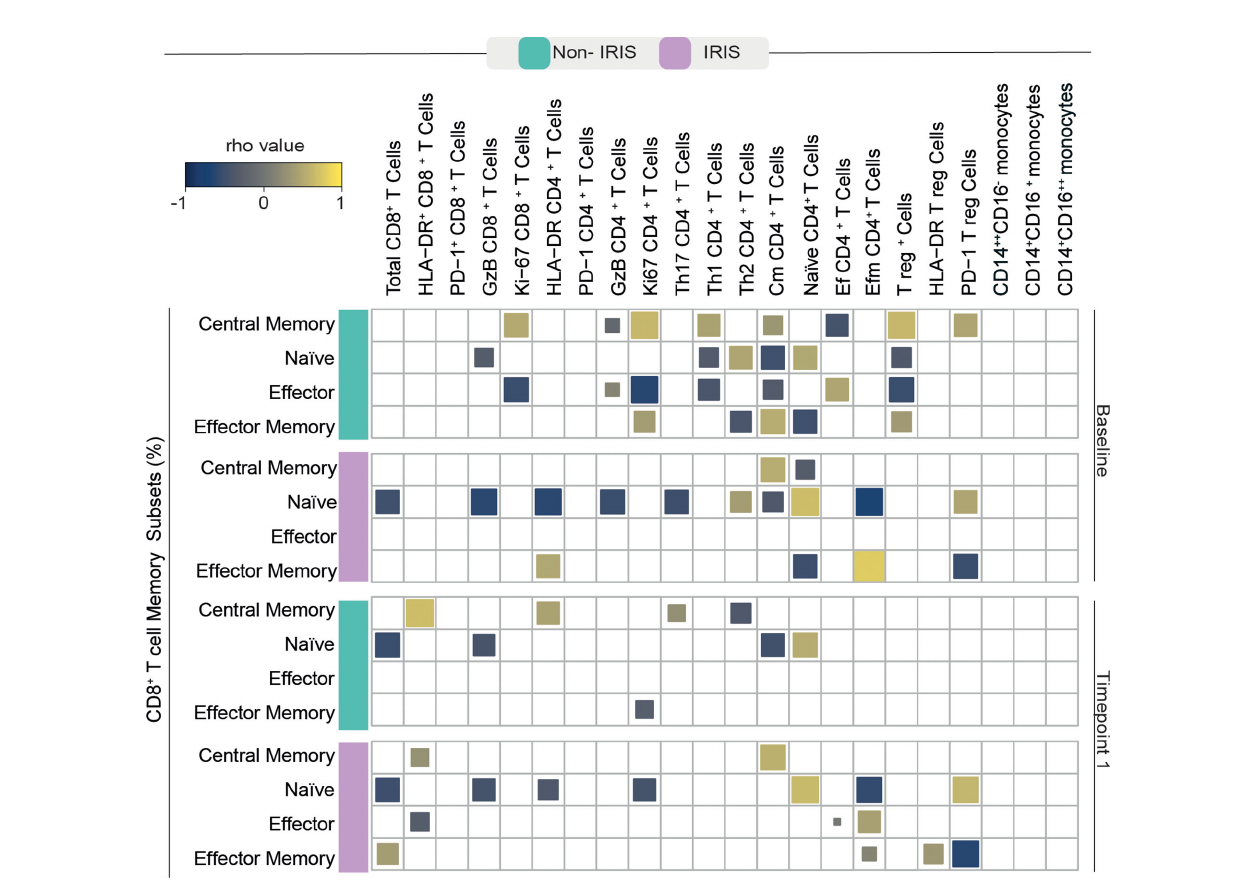
FIGURE 3 | Spearman correlations between CD8 + T cell memory subsets and activated adaptive and innate immune cells. A Spearman-based correlation matrix was employed to depict the strength of association among percentages of the memory subsets of CD8 + T cells and the frequency of other activated immune cells at Baseline (before ART) and after approximately 2 to 6 weeks following ART initiation (timepoint 1) for Non-IRIS and TB-IRIS subjects. Statistically signi fi cant correlations (P<0.05) after adjustment for multiple measurements are highlighted as yellow squares (positive correlations) or blue squares (negative